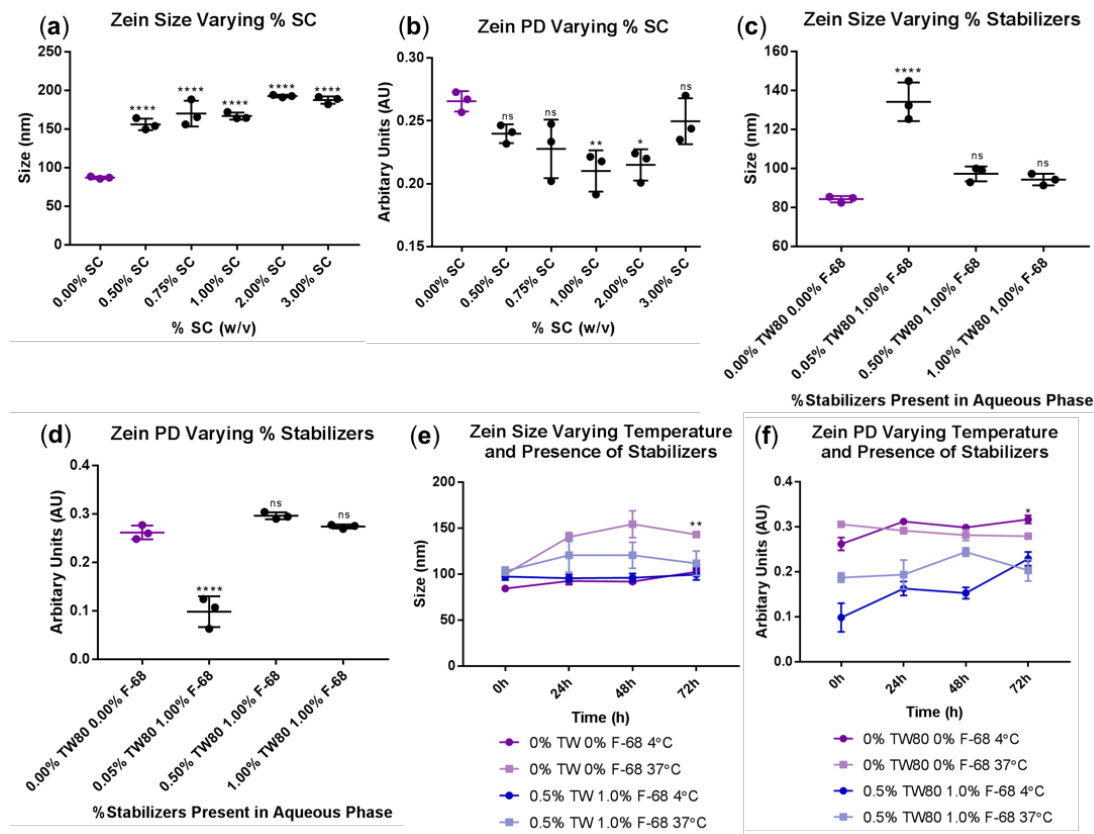
Figure 7. The ability to functionalize Zein nanoparticles (NPs) using a microfluidics system as demonstrated by: ( a ) the diameter of Zein NPs’ varying% of sodium caseinate (SC); ( b ) the polydispersity (PD) of Zein NPs’ varying% SC; ( c ) the diameter of Zein NPs’ varying% of stabilizers; ( d ) the PD of Zein NPs’ varying% stabilizers; ( e ) the diameter of Zein NPs’ varying temperatures and presence of stabilizers; and ( f ) the PD of Zein NPs’ varying temperatures and presence of stabilizers.